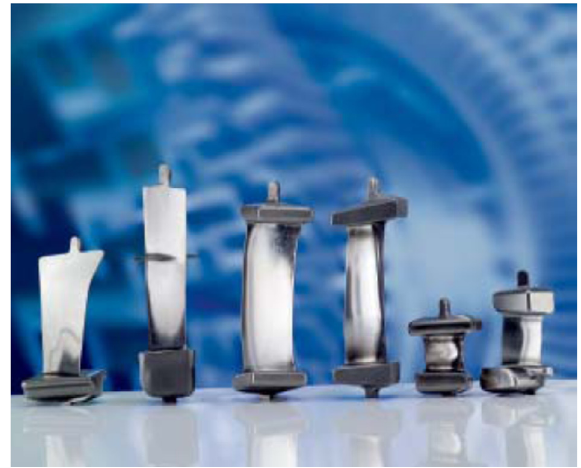
Figure 6. Forged compressor blades